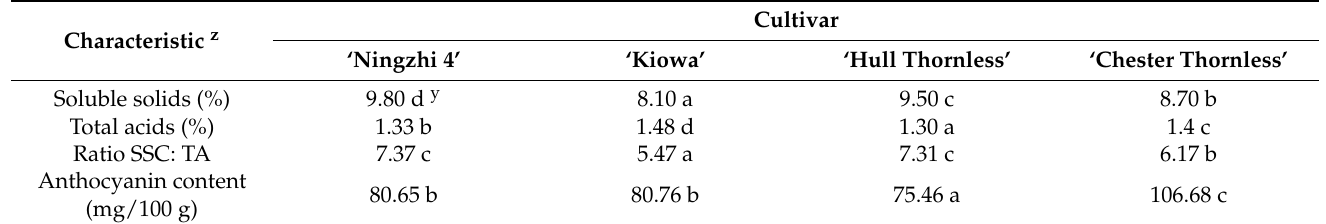
Table 2. Soluble solid content (SSC), total acid (TA) content and anthocyanin content of four black- berry cultivars in Nanjing in